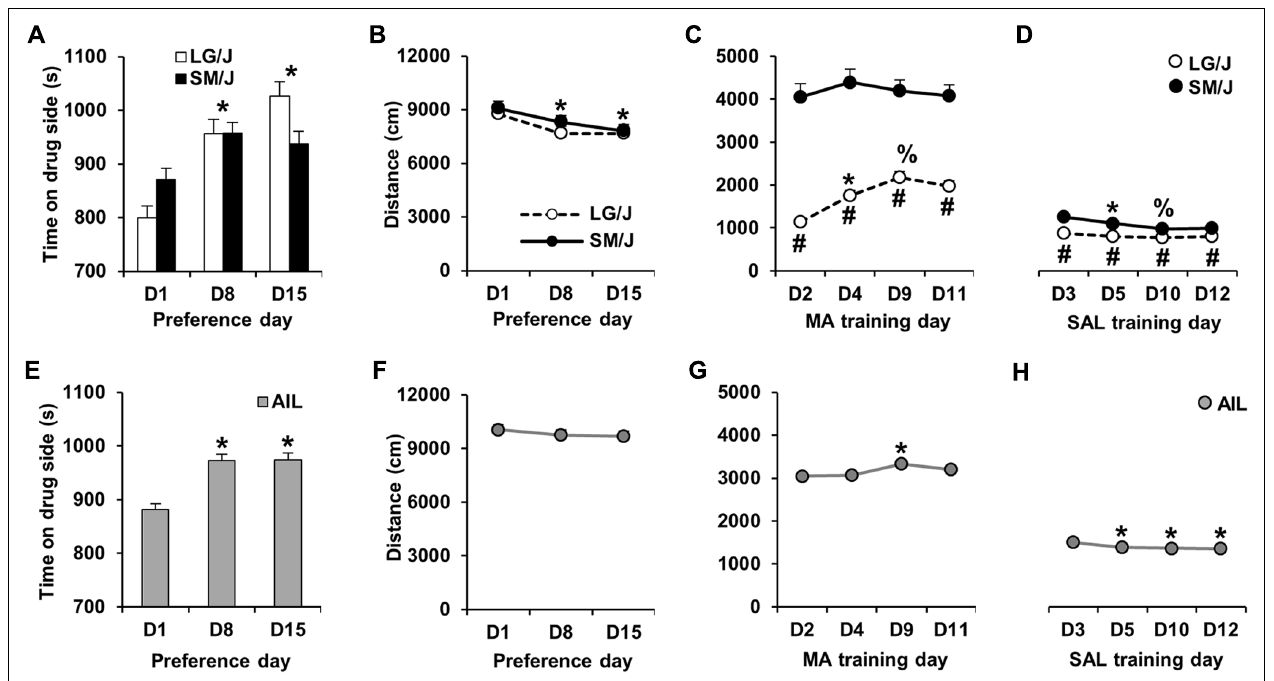
FIGURE 2 | MA-CPP and MA-ACT in LG/J, SM/J, andAIL mice. (A,E) Time spent on the MA-paired side (s) on D1 and then on D8 and D15 following alternating MA and SAL trials. LG/J mice ( N = 31) are represented by white bars, SM/J mice ( N = 31) are represented by the black bars, and AIL mice ( N = 105) are represented by gray bars. (B,F) Locomotor activity (total distance traveled in cm; summed over 30 min) in LG/J (white circles), SM/J (black circles), and AIL mice (gray circles; N = 105) during days of preference